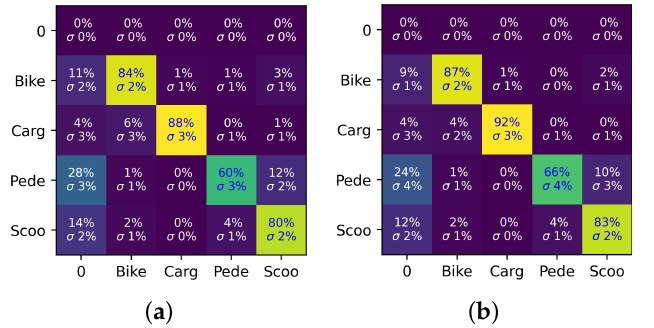
Figure 11. Row-wise normalized RBF confusion matrices of ( a ) 16 × 16 scaled ROI and ( b ) 12 × 18 combined scaled ROI and contour moments, with true labels on the y axis and predicted labels on the x axis.